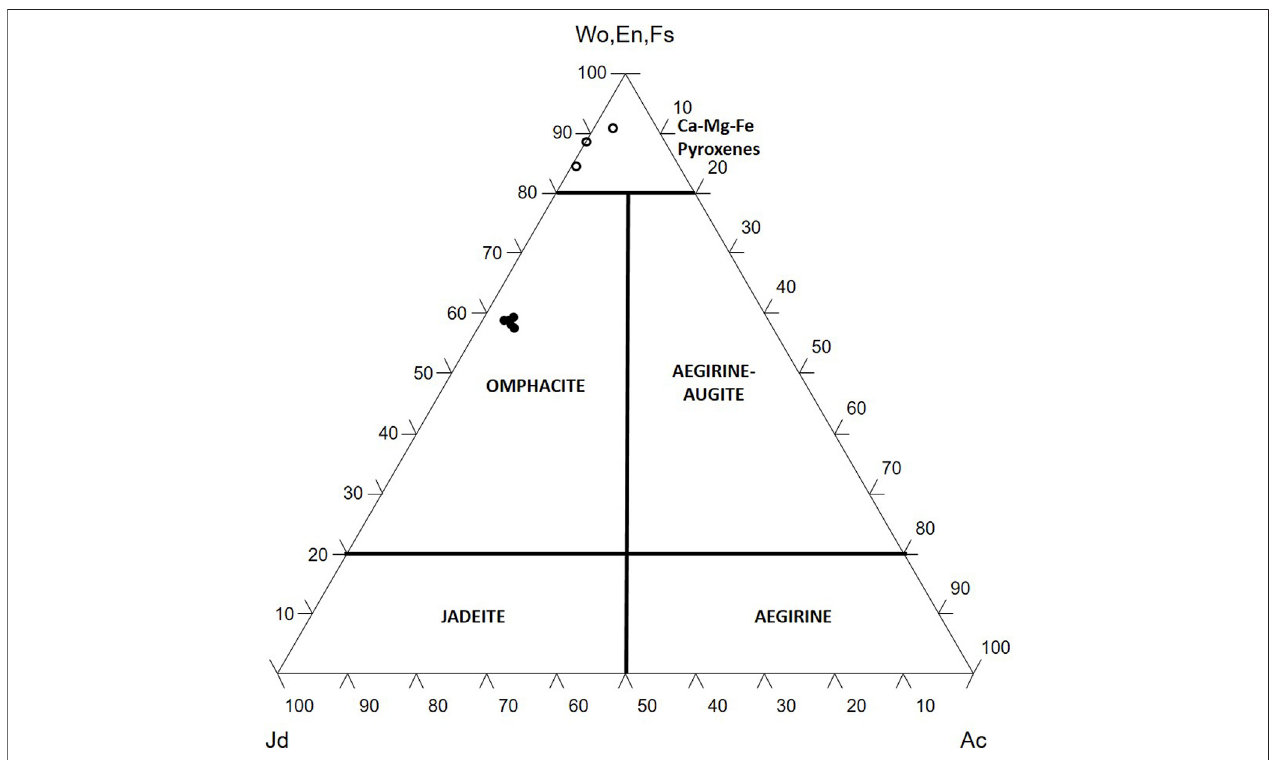
FIGURE 6 | Triangular plot showing the compositional fi eld of omphacite from retrograde eclogites. Jd, jadeite; Ac, acmite; Wo, wollastonite; En, Enstatite; Fs, Ferrosilite.